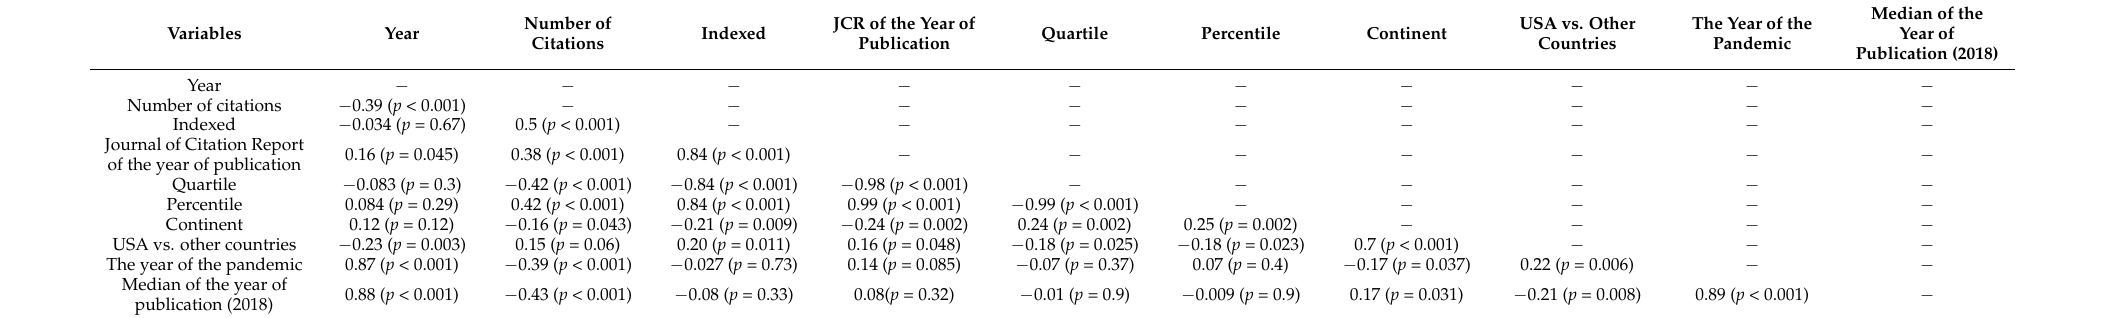
Table A1. Correlation and p -values between the variables of the bibliometric analysis.